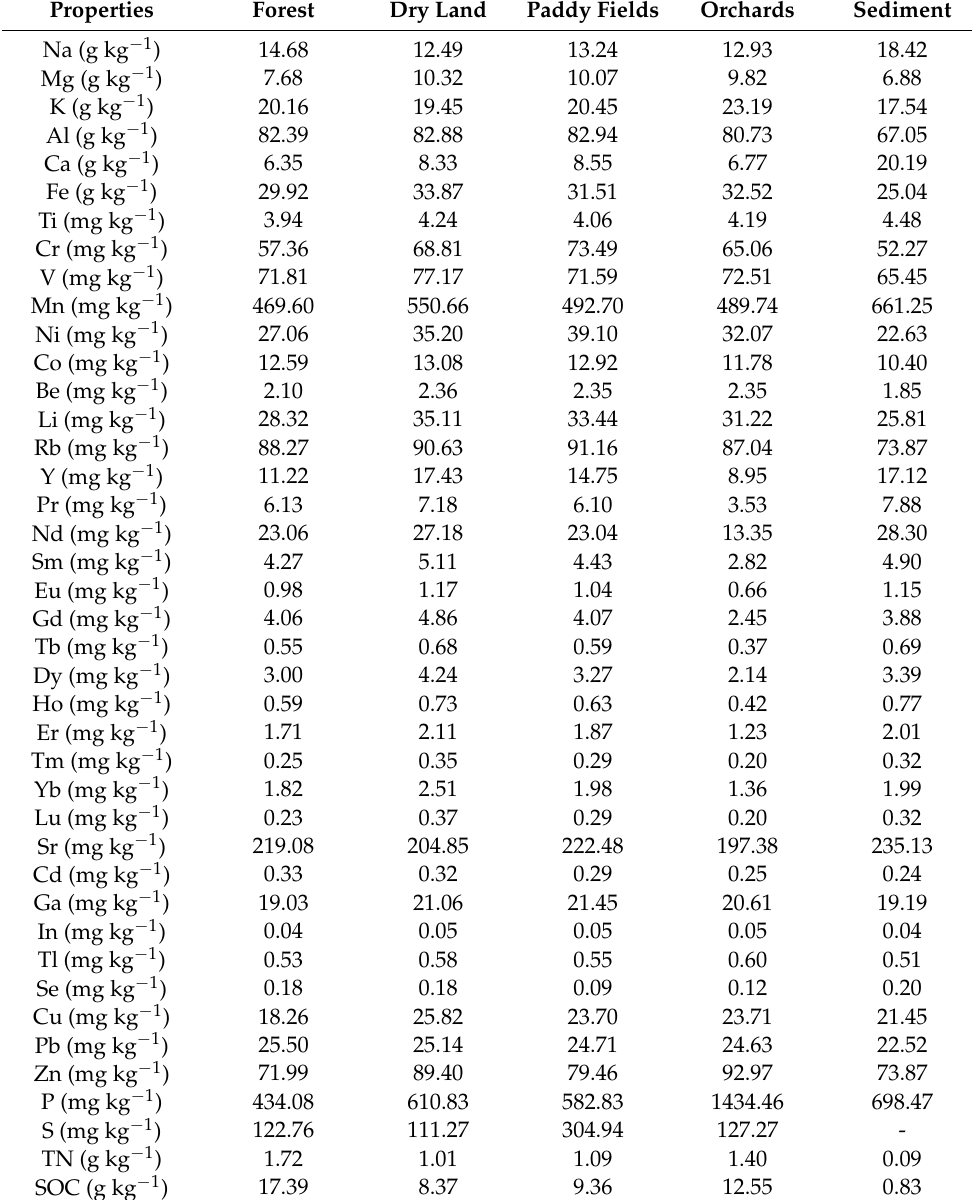
Table 2. Mean concentrations of elements of sources and sediments.